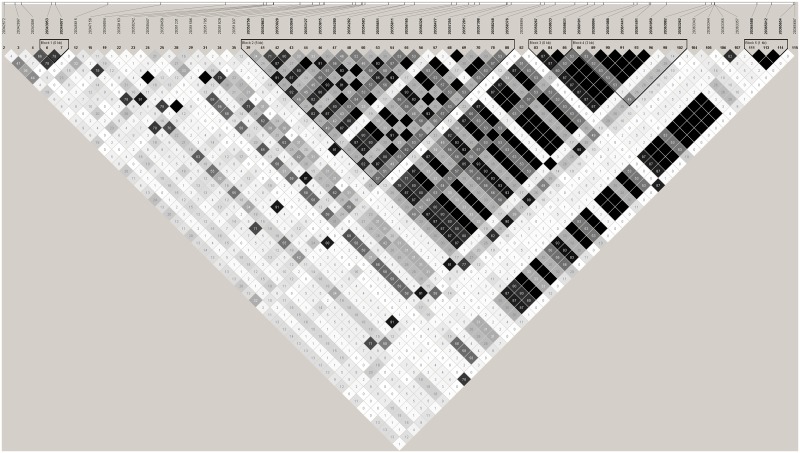
Linkage disequilibrium plot using r2.Linkage disequilibrium plot for all SNPs with minor allele frequency >5% and in Hardy-Weinberg Equilibrium. Colour scheme for r2 plot as follows: r2 = 0 (white), 0 < r2 < 1 (shades of grey), r2 = 1 (black).